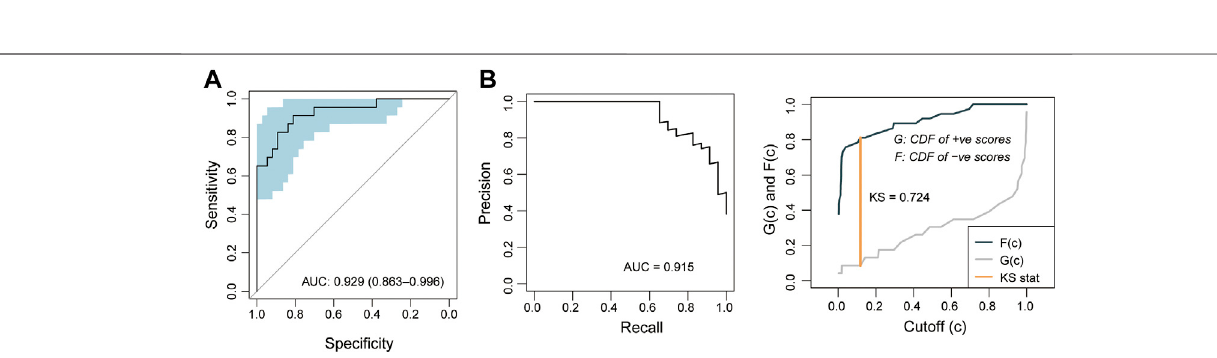
Frontiers in Genetics |